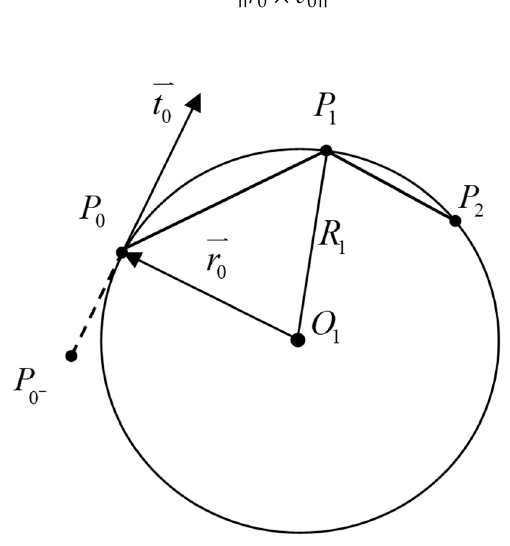
Figure 4. Curvature estimation of endpoint 𝑷 𝟎